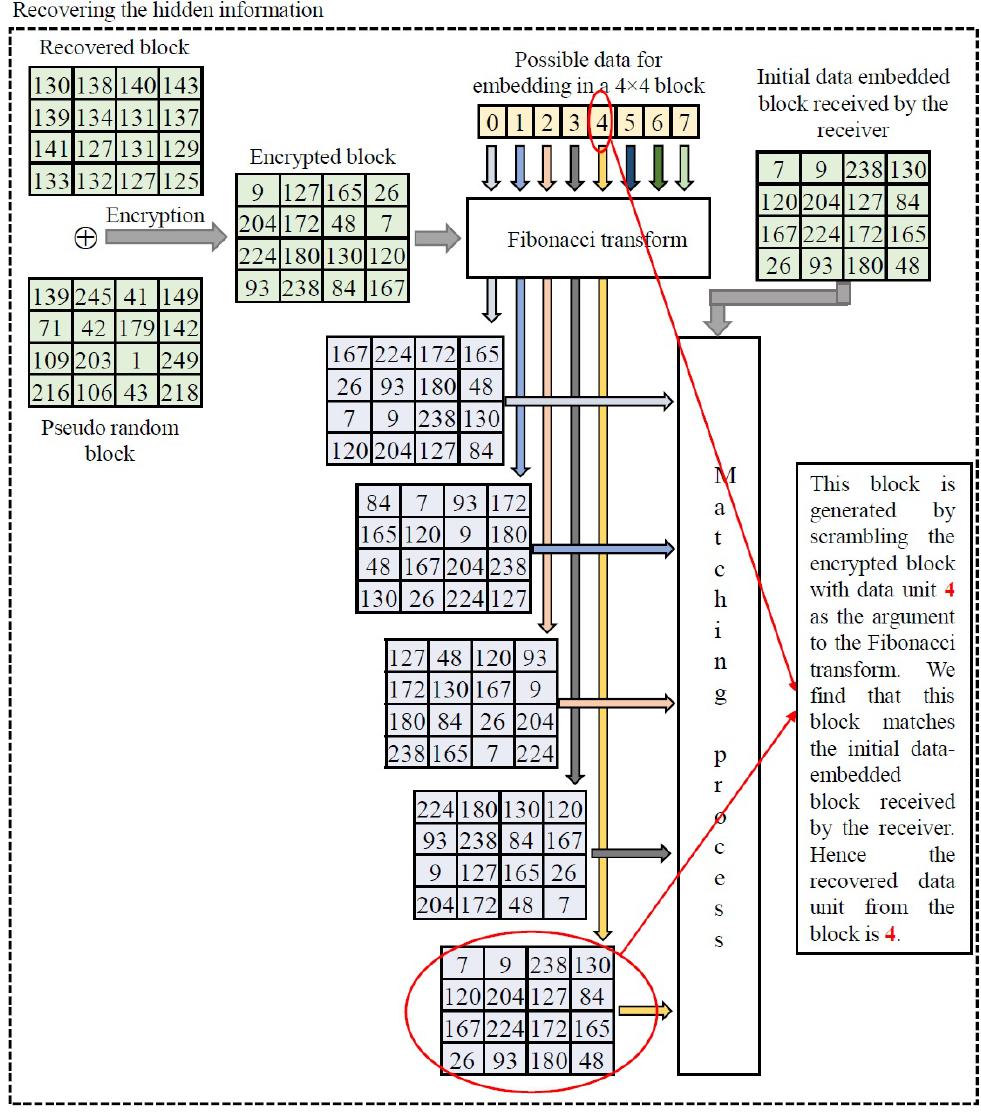
Figure 4. Illustration of the recovery of the hidden secret